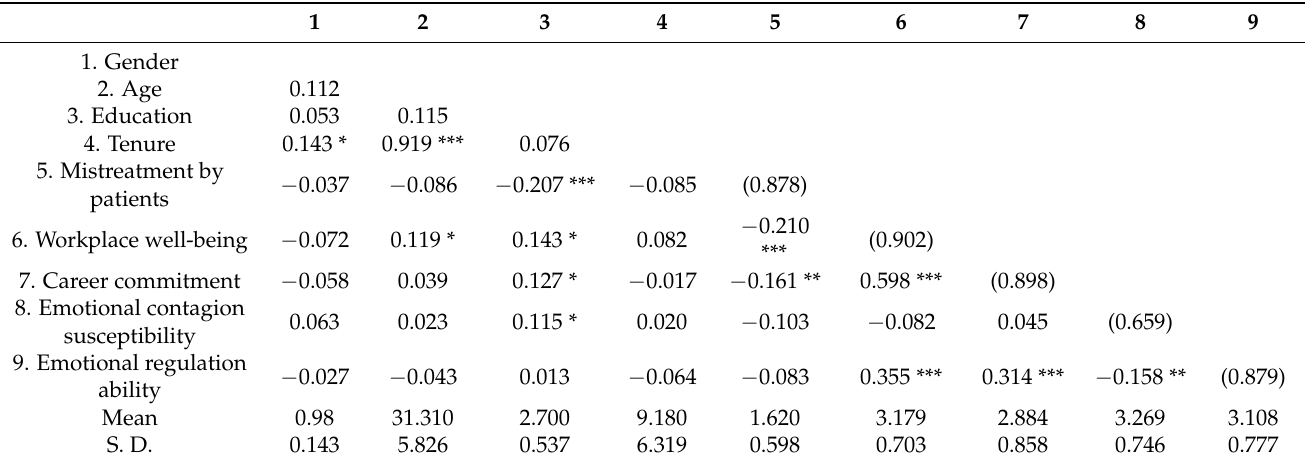
Table 1. Means, standard deviation, and correlations between study